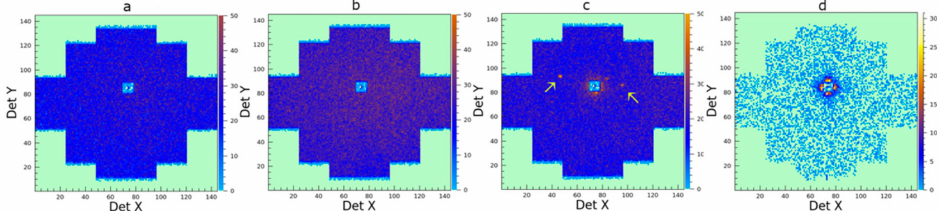
Figure 3. The two-dimensional SANS patterns corrected for detector sensitivity collected at L D = 1.5 m from: empty beam ( a ), when the two Al-coated quartz windows (items 3 and 4 in Figure 1a) are added ( b ), and when the two ZnSe windows are added ( c ); data from the same setup as in ( c ) but collected at L D = 20 m are shown in ( d ). The yellow arrows indicate the Bragg reflections from the ZnSe